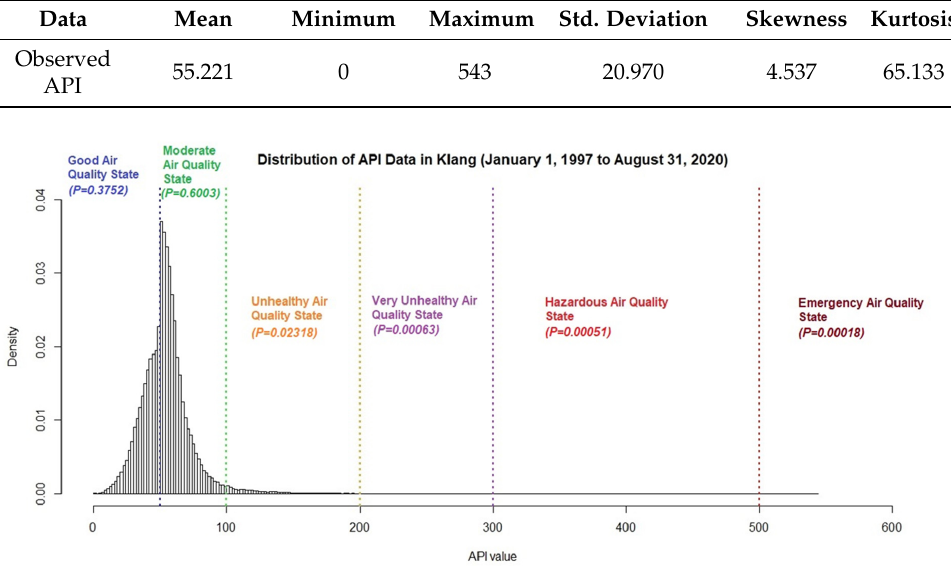
Table 2. Descriptive statistics for the air pollution data in Klang.